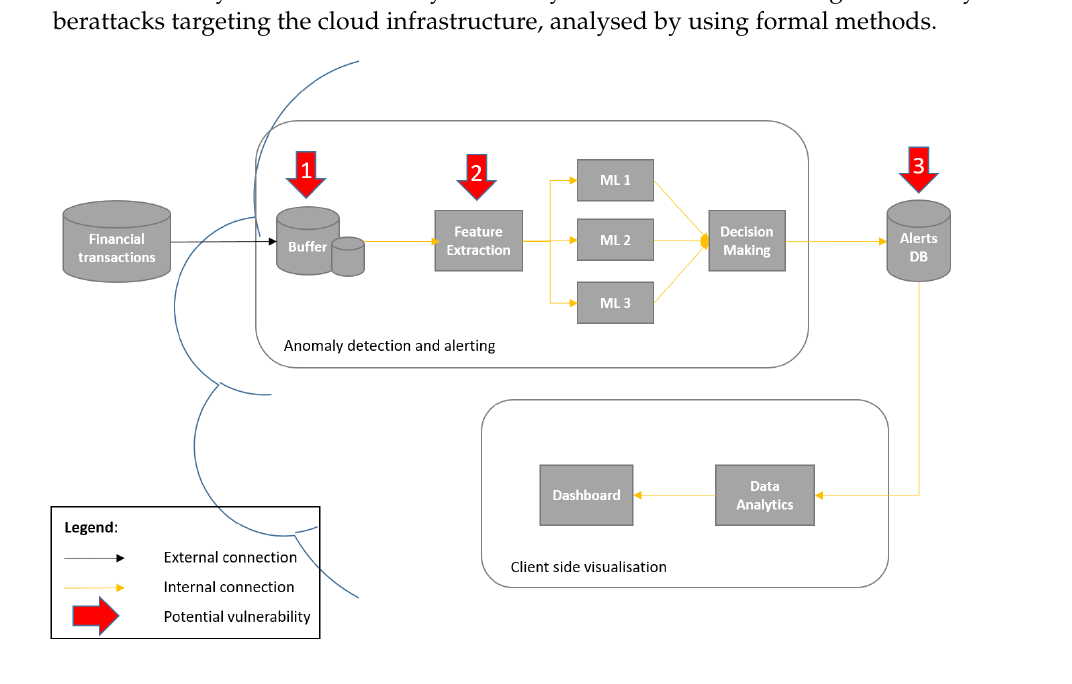
Figure 1. Financial fraud alerting system based on parallel anomaly detectors.